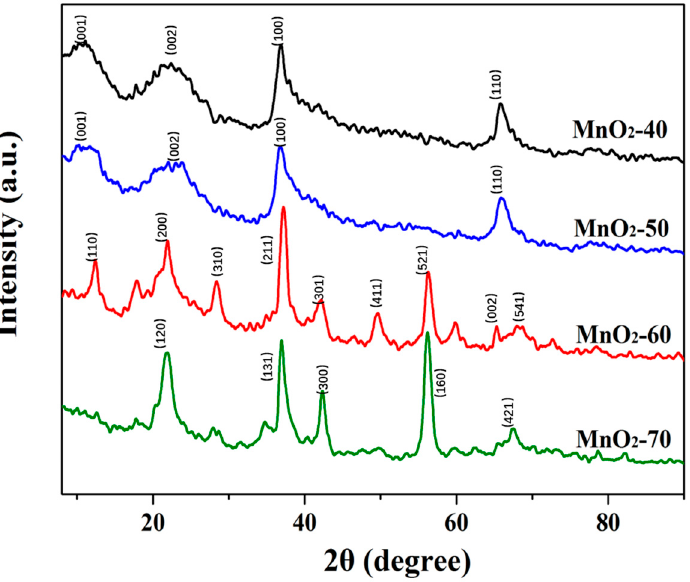
Figure 5. X-ray diffraction (XRD) patterns of MnO 2 prepared at different temperatures.